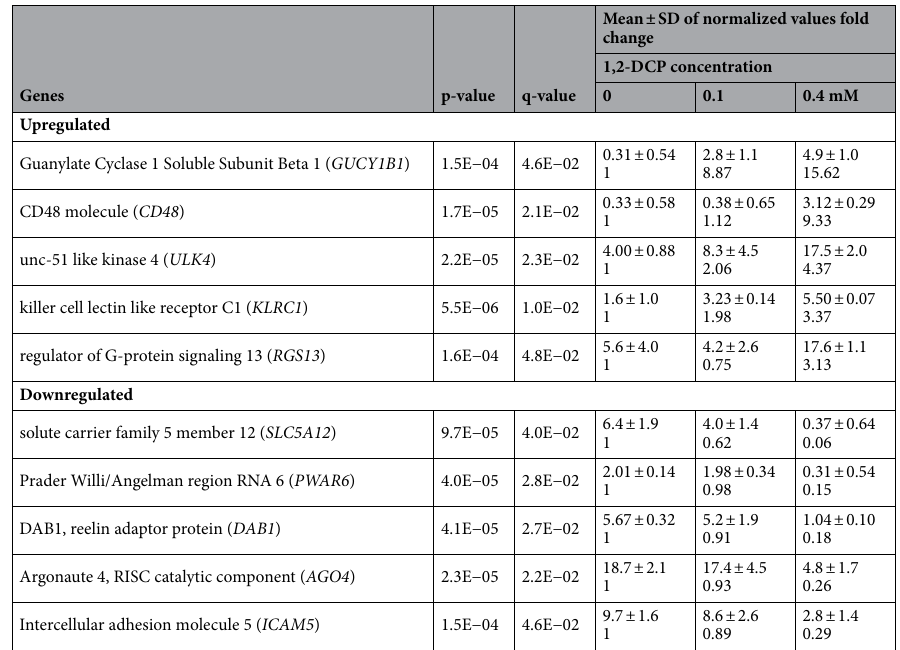
Table 5. Genes whose expression changed dose-dependently following exposure of 1,2-DCP to THP-1 macrophages co-cultured with MMNK-1 cholangiocytes. We tested the significance of Pearson correlation coefficient between the expression of each gene and 1,2-DCP level. The table lists the top or bottom five genes with the largest fold change at 0.4 mM in THP-1 macrophages co-cultured with MMNK-1 cholangiocytes when exposed to 1,2-DCP at 0, 0.1 or 0.4 mM for 24 h. Data of normalized values for gene expression are mean ± SD, n = 3. All p-values for gene expression were adjusted using Benjamini–Hochberg method and expressed as q- values. Fold change represents the value relative to the average of the control group (0